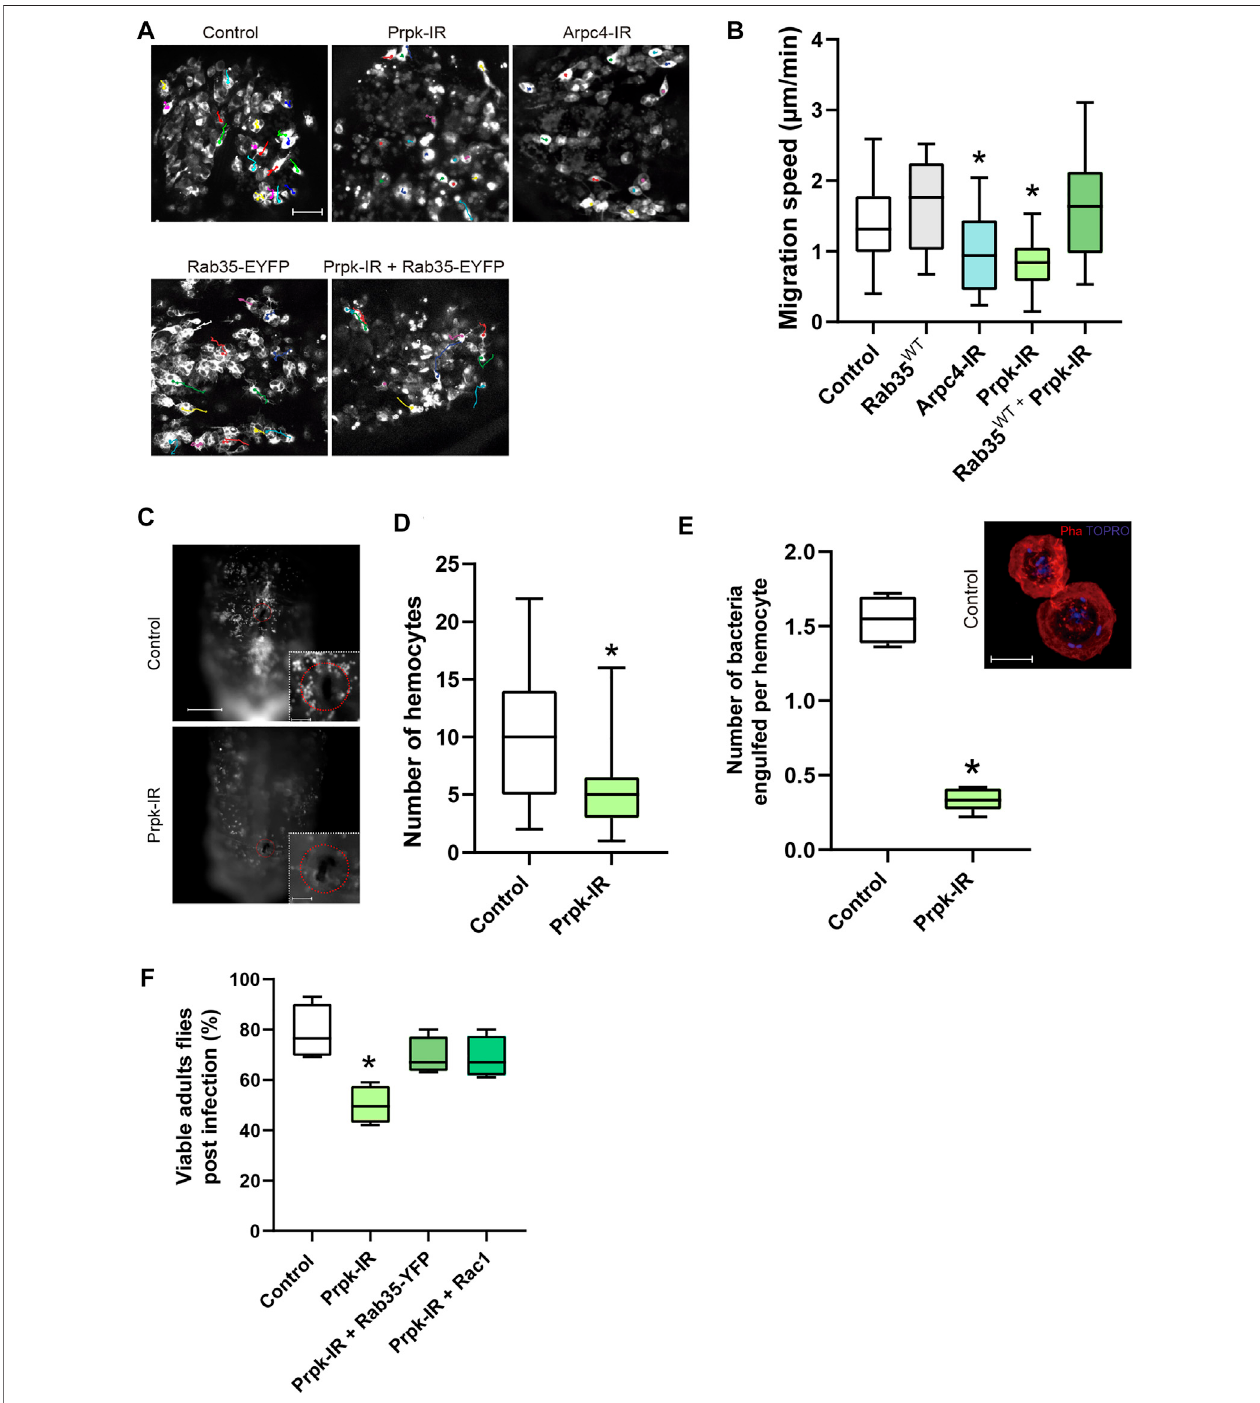
FIGURE 5 | Prpk is essential for hemocyte recruitment, migration and phagocytosis during the immune response. (A) Time-lapse of Z-stack projections of pupal hemocytes of 15 – 20 h after puparium formation (APF) expressing GFP speci fi cally in hemocytes with the Hml-Gal4 driver (Hml-Gal4, 2xEGFP): Hml-Gal4, 2xEGFP (Control),overexpressionofRab35 WT -YFP(Rab35-EYFP),Prpk-IR,co-expressionofPrpk-IRandRab35 WT -YFPandArpc4-IR. (B) Quanti fi cationofmigrationspeedfor each condition. The trajectories of hemocytes were labeled by color tracks. * corresponds to p < 0.05 (Kruskal – Wallis test, n = 4, where at least seven hemocytes were quanti fi ed per animal). Scale bar: 50 μ m. (C) Recruitment assay in response totissuedamage. Scale bar: 150 μ m in full-images and 50 μ m in zoomed images. (D) Thenumberofhemocytesrecruitedtothewoundsitewerequanti fi ed6 hafterdamageincontrolandPrpk-IRlarvae.*means p < 0.005(Mann-Whitneytwo-tailedtest,n = 3, 10 larvae per experiment). (E) Quanti fi cation of the number of bacteria engulfed per hemocytes. * corresponds to p < 0.01 (Mann-Whitney two-tailed test, n = 5). Z-Stack Projections of control hemocytes fi xed and stained after phagocytosis assays. F-actin stained with Phalloidin (Pha, red), and DNA with TO-PRO (blue). The presence of internalized E.coli bacteria is evidenced by small rod-shaped TO-PRO staining. Scale bar: 10 μ m. (F) Chart depicting the percentage of viable adult fl ies subjected to infection with E.coli .* correspond to p < 0.05 (Mann-Whitney two-tail test, n = 4, 20 fl ies per experiment).